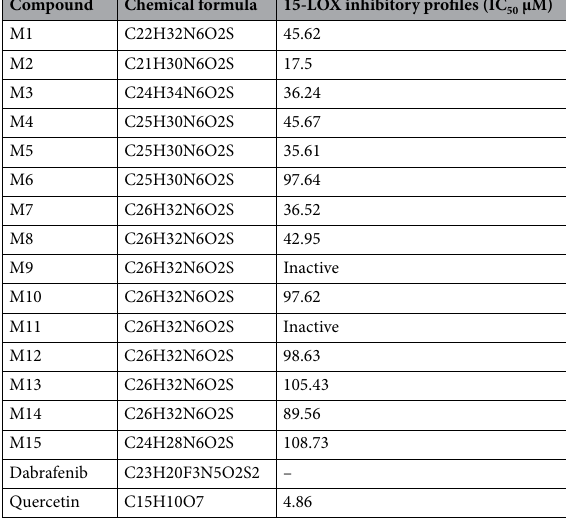
Table 5. Chemical formula and 15-LOX inhibitory profile of all